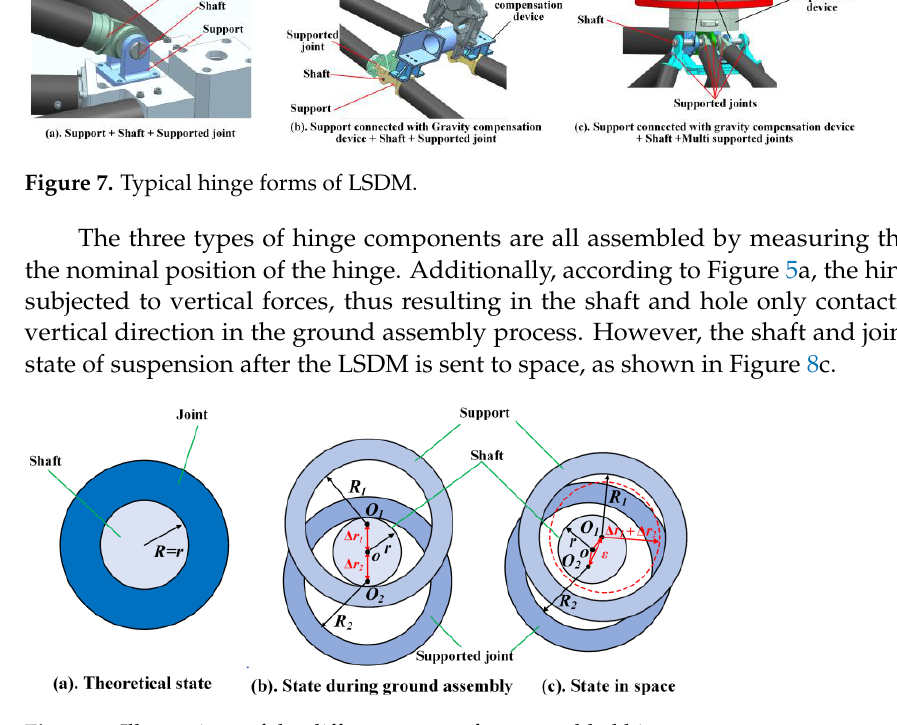
Figure 6. The length of the truss rod in different environments.